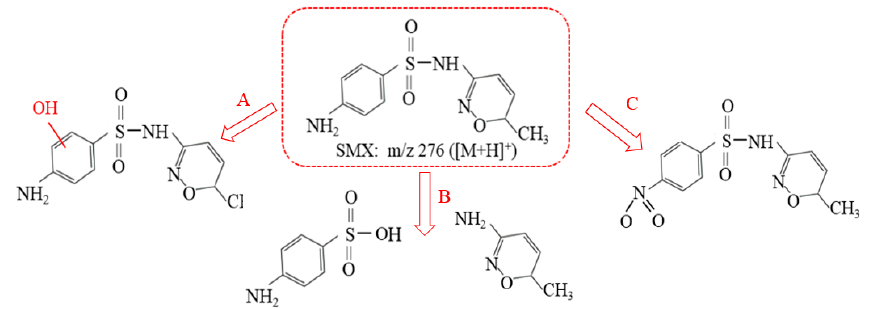
Figure 6. Reaction pathways of SMX and the major intermediates observed in this study.